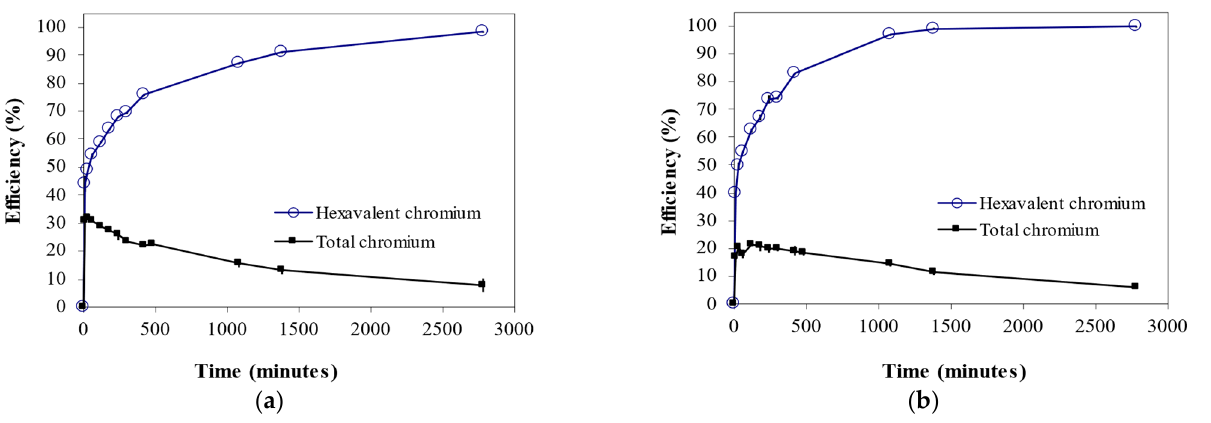
Figure 3. Contact time effect on chromium biosorption efficiency by inactive biomass of ( a ) B. mega ‐ terium and ( b ) Rhodotorula sp. (pH = 1, biosorbent dose = 8 g/L, temperature = 25 °C, initial concen ‐ tration = 101.23